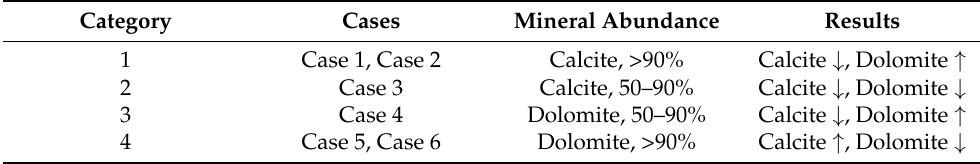
Table 7. The changes in the calcite and dolomite abundance.